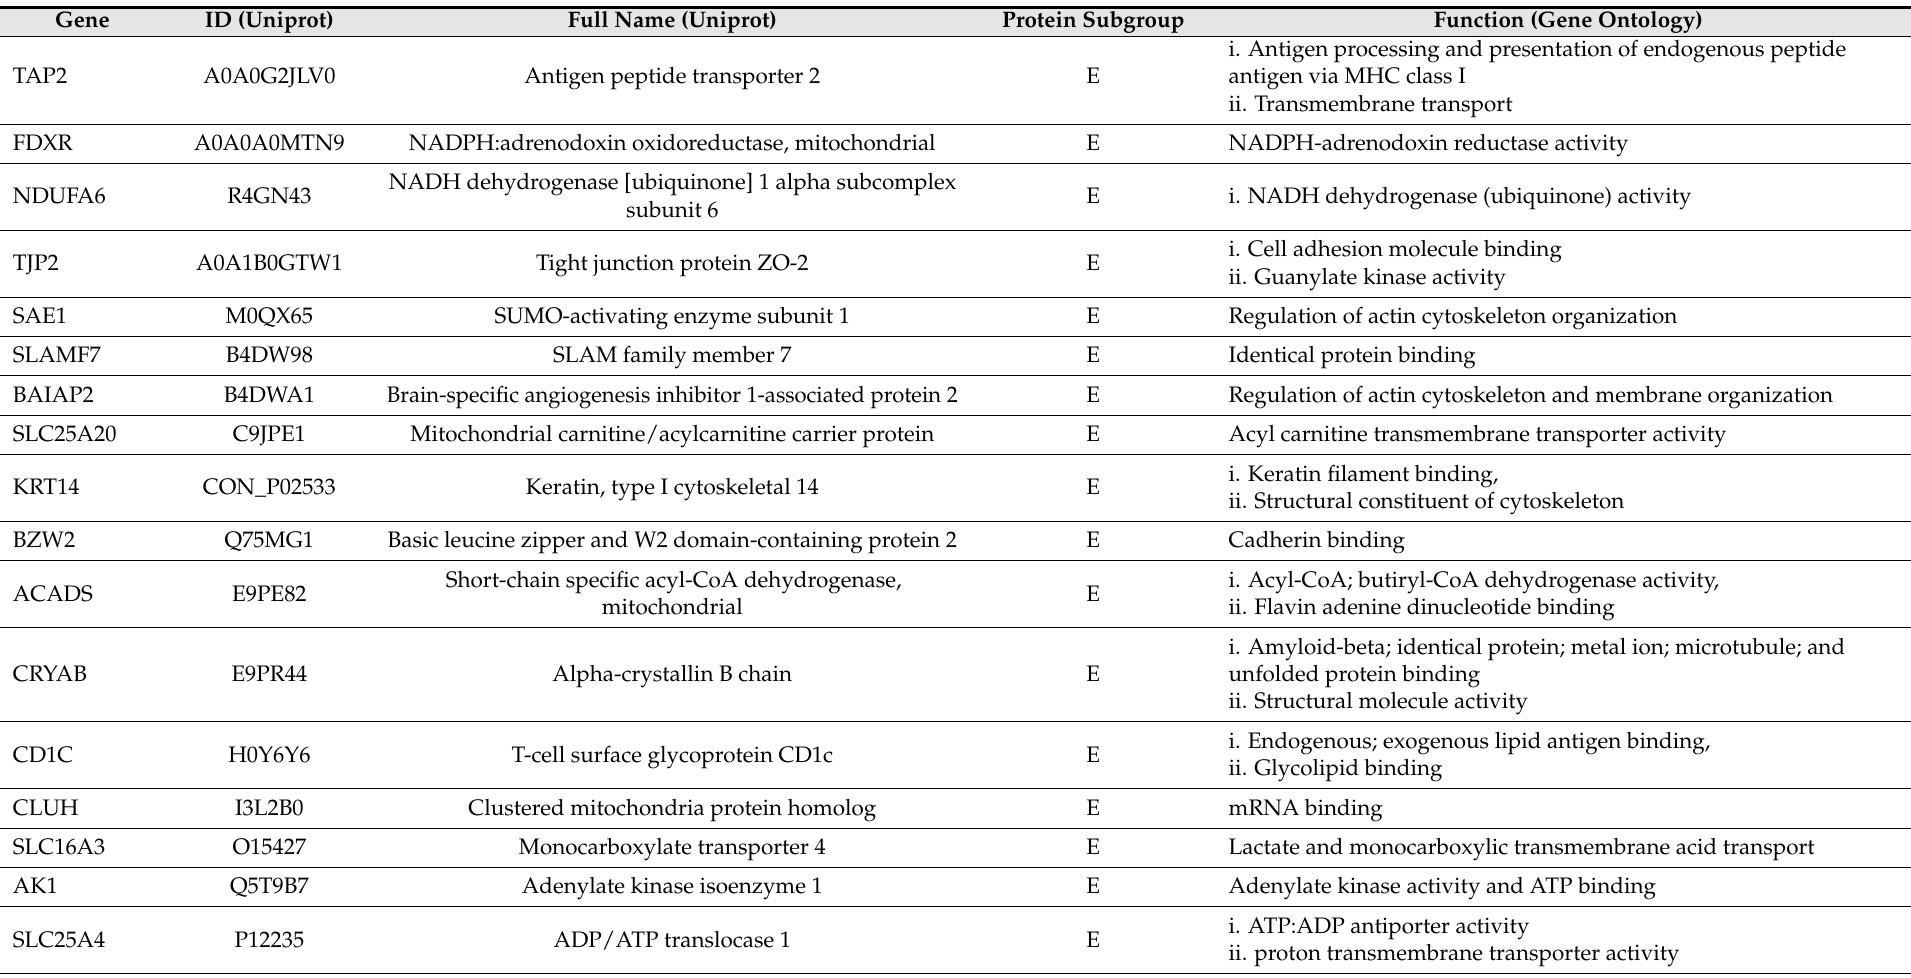
Table 1. Currently known functions of the 83 selected gene-proteins regulated by HP (showed in Figure 1C). The list of proteins was previously filtered by exclusivity or abundance (log2(Fold Change)) > 1, when comparing HP vs.